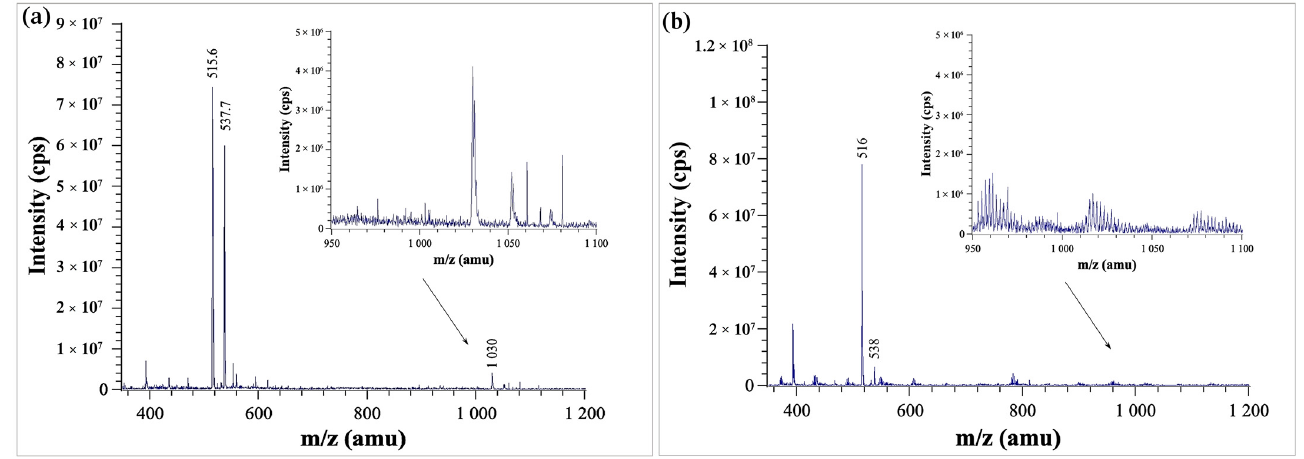
Figure 6. ( a ) MS spectra of buffer-free saturated solution at pH 3–8, ( b ) MS spectra of buffer-free saturated solution at pH = 10.